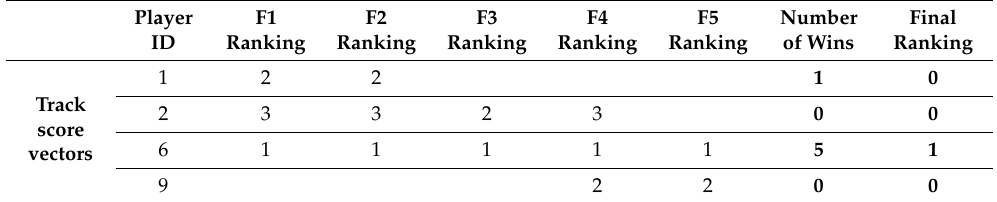
Table 1. The track score vectors for each detected player on video sequence is presented in Figure 7. Number of wins for each player in a sequence and final rankings are highlighted.